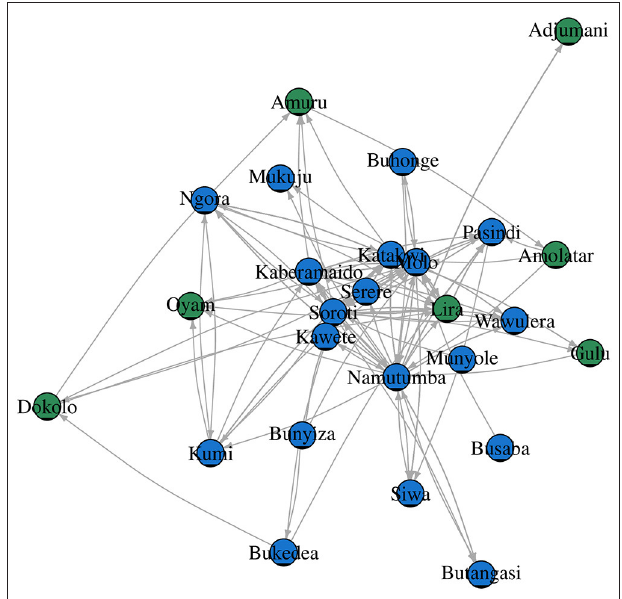
FIGURE 3 | Cattle trade network in northern (green nodes) and eastern (blue nodes)